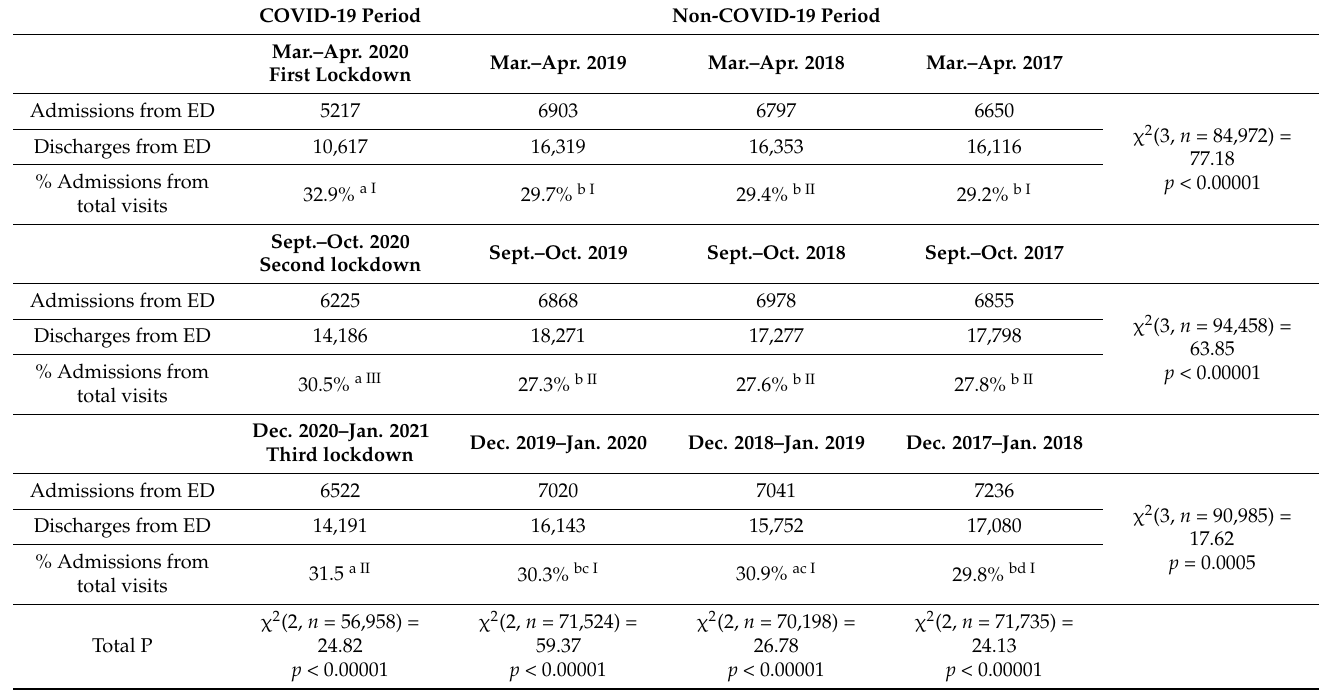
Table 1. Number of admissions vs. discharges from the emergency